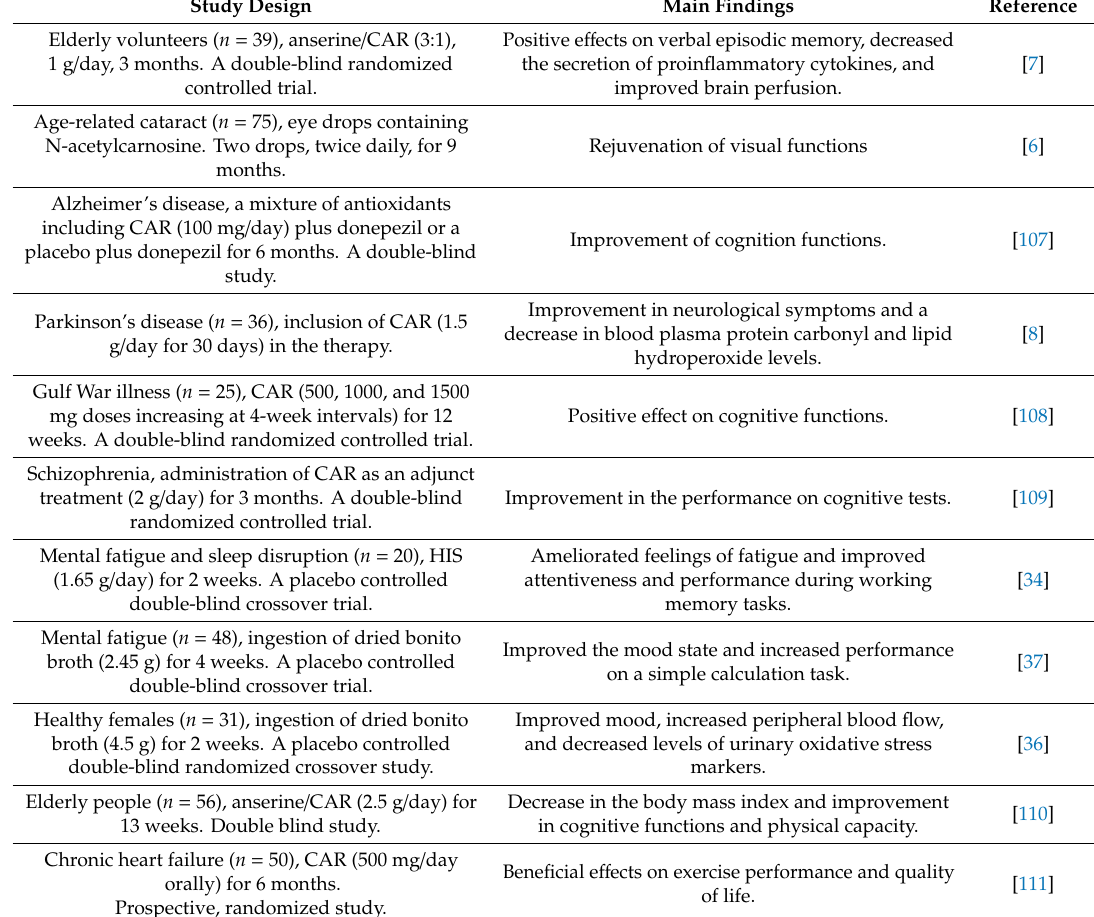
Table 3. E ff ects of HIS and HIS-containing dipeptides (HIS-CD) on the elderly and ageing-related disorders. Study Design Main